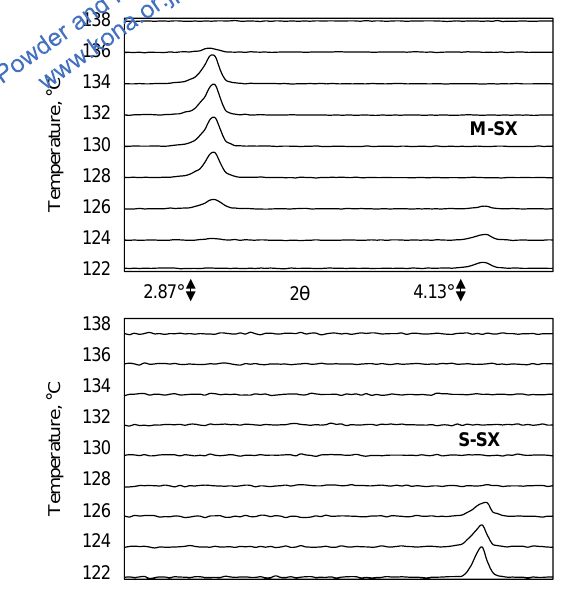
Kinetics of melting and recrystallization of M-SX and S-SX compounds as shown by time-resolved small-angle X-ray diffraction. Heating rate is 10°/min. The characteristic dif- fraction peaks correspond to the (001) reflections with d - spacing: d 001 (cid:4) 21.348 Å (form I) and d 001 (cid:4) 30.708 Å (form